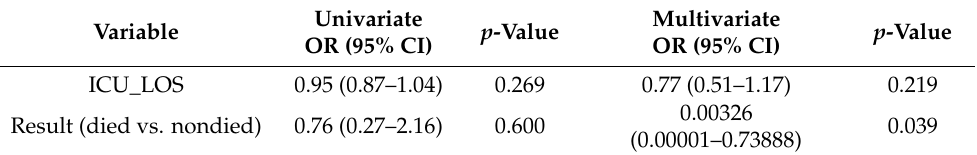
Table 3. Logistic regression analysis of risk